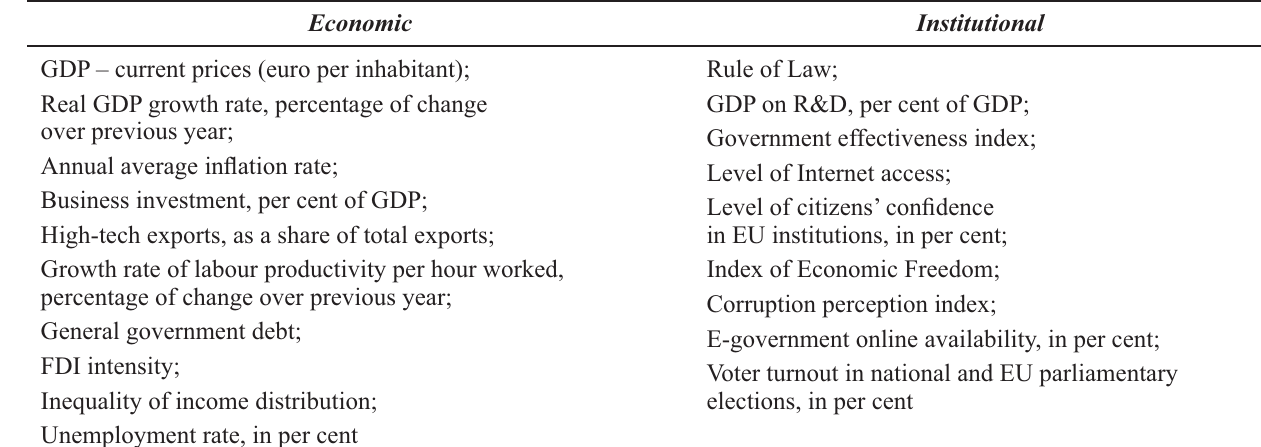
Table 1. Indicators’ set characterizing sustainable development with emphasis on institutional